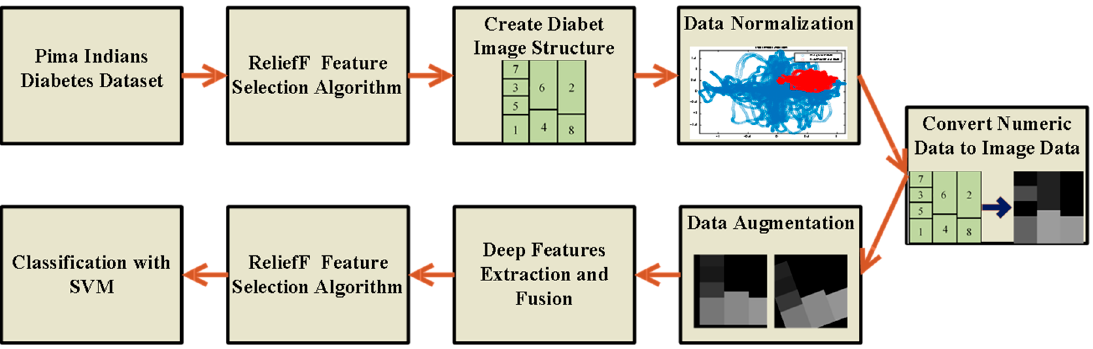
Figure 8. Application flow chart in the last step.